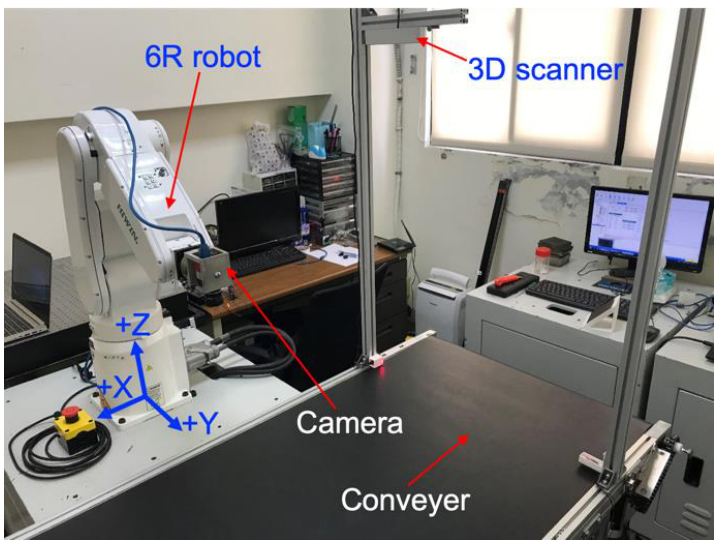
Figure 1. Experimental setup of the inline inspection (X-Y-Z is the origin of the robot coordinate).